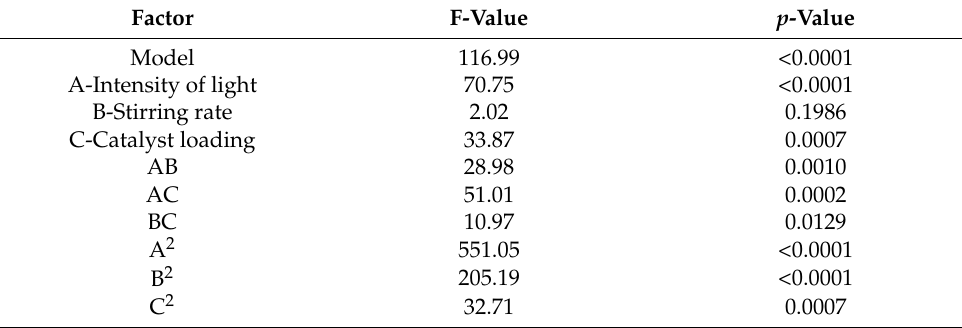
Table 5. Analysis of the ANOVA